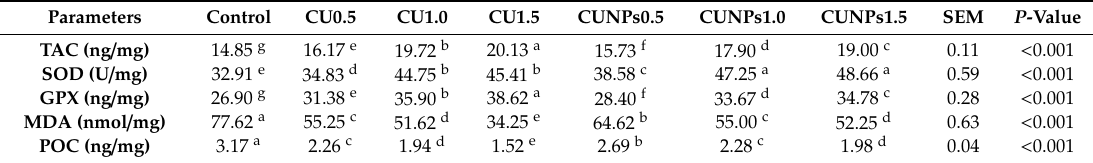
Table 3. E ff ect of di ff erent levels of curcumin (CU) and curcumin nanoparticles (CUNPs) on antioxidants indices post-thawed rabbit sperm (mean ± SEM).